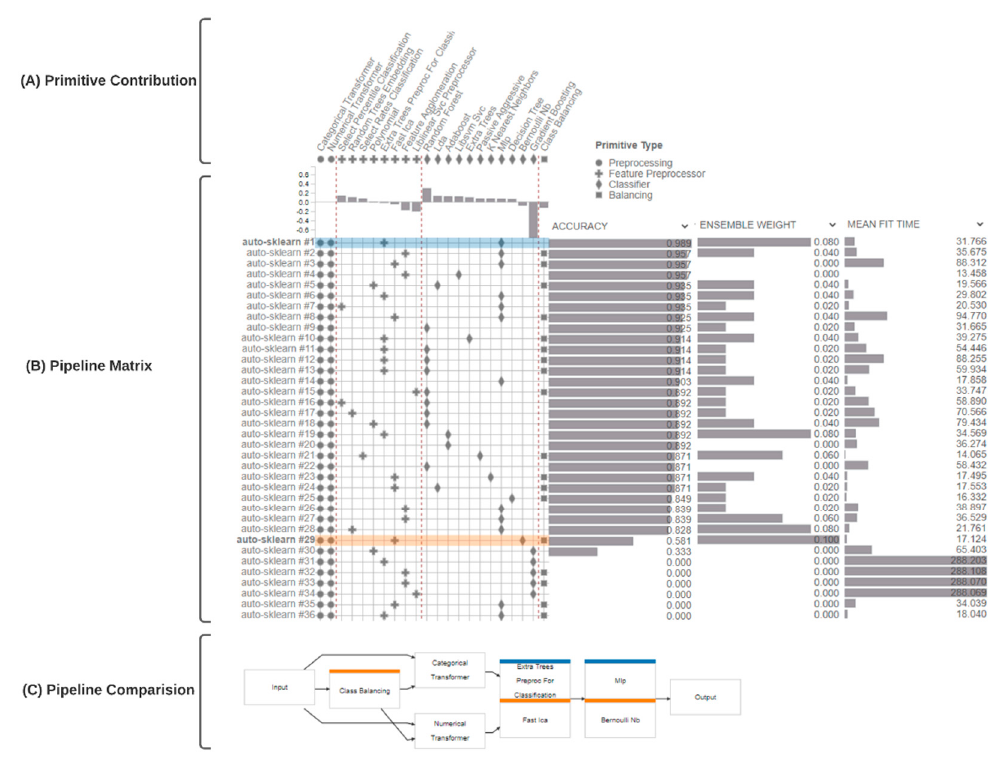
Figure 8. PipelineProfiler applied to the analysis of salmon meat classification pipelines generated by AutoML systems .